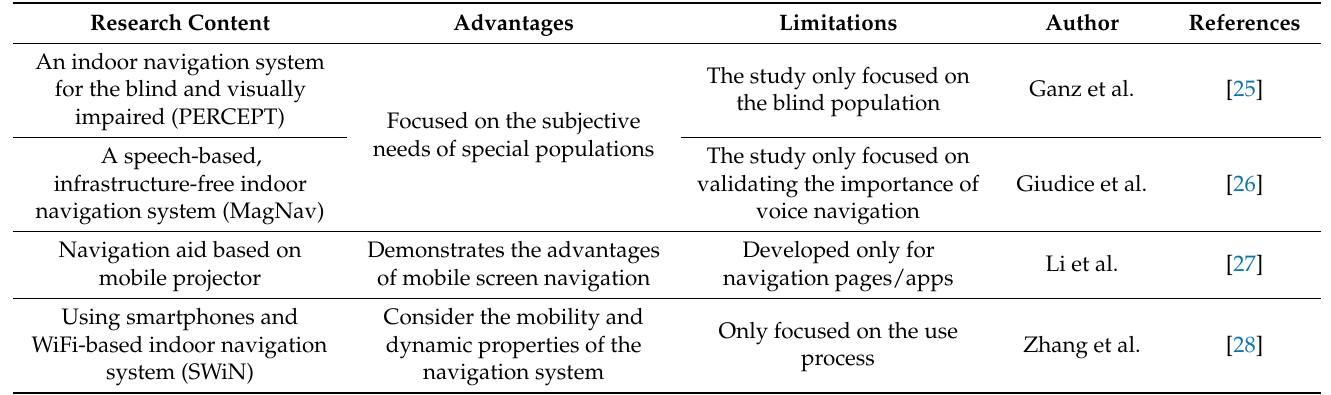
Table 1. Comparison between the method in this paper and the existing